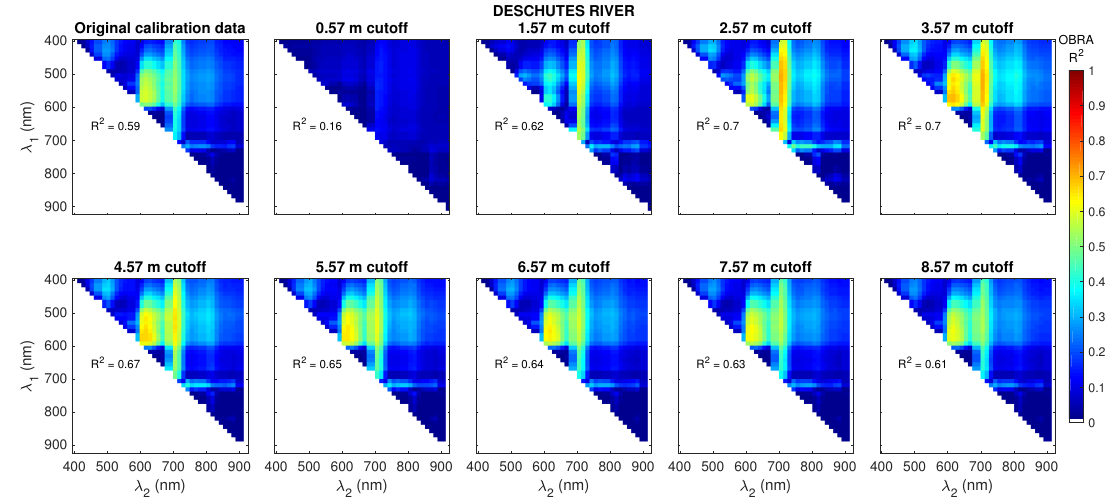
Figure 4. Optimal Band Ratio Analysis (OBRA) matrix based on spectra extracted from the Deschutes River hyperspectral image for the original field data from the multibeam echo sounder survey, followed by OBRA matrices for a series of cutoff depths from OBRA of Progressively Truncated Input Depths (OPTID).